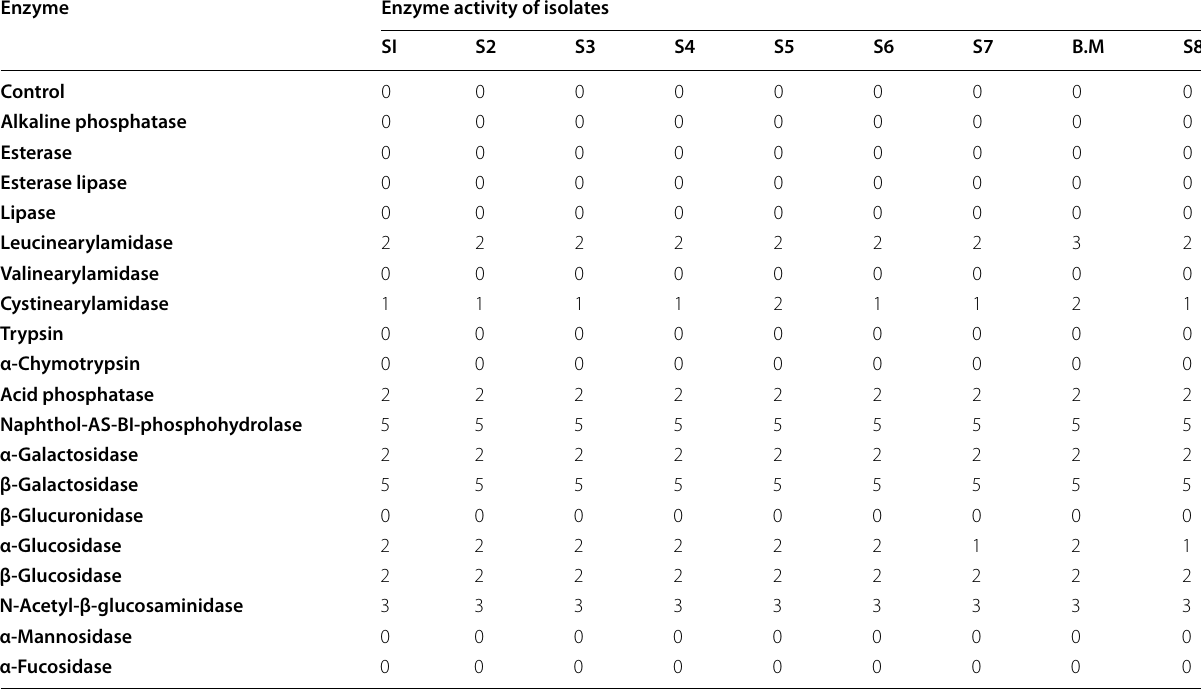
Table 1 Enzyme activity of isolated Lactobacillus